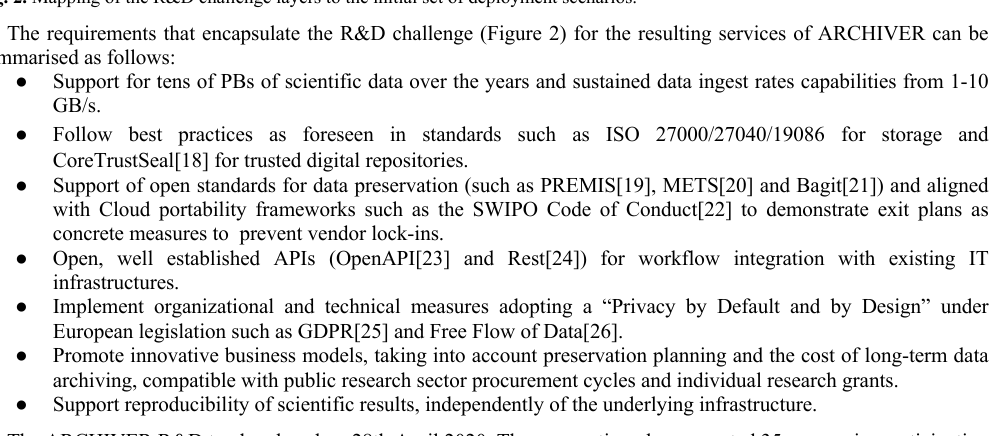
Fig. 2. Mapping of the R&D challenge layers to the initial set of deployment